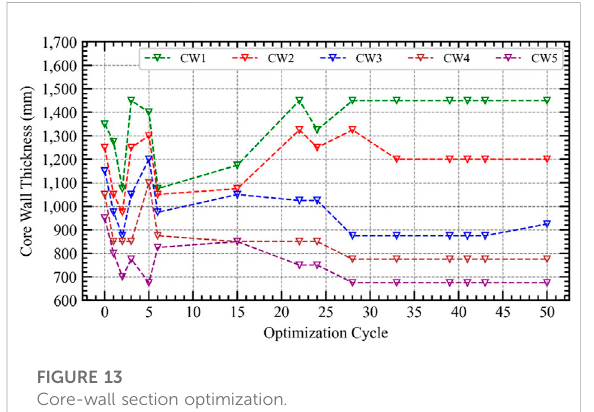
FIGURE 15 Beam section optimization.